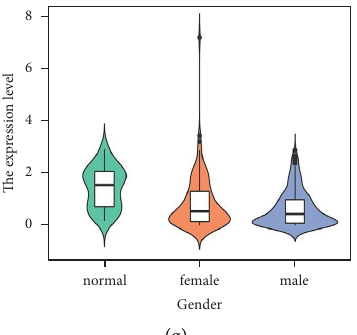
Figure 5: Expression of important DEGs in HCC patients with diferent genders: (a) MAFG-DT; (b) GSTZ1; (c) GPRIN1; (d) MYBL2; (e) LINC00907; (f) CCN1; (g) GSTM5 ( ∗ P < 0 . 05, ∗∗∗ P < 0 . 001).